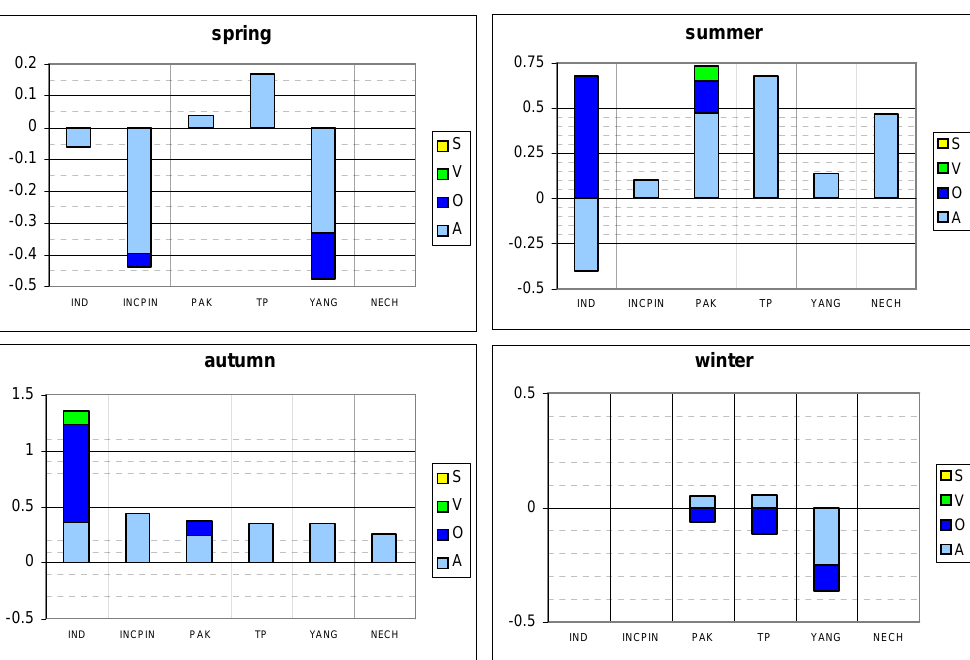
Fig. 8. Same as Fig. 5, but for precipitation anomalies [mm/day]. Please note the change in